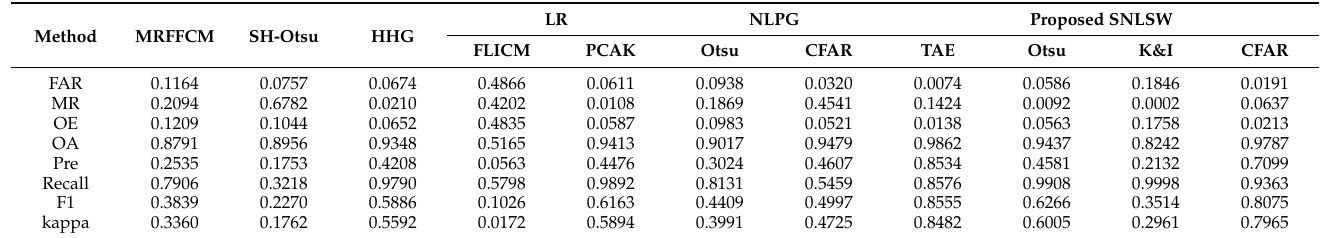
Table 3. Quantitative evaluation of the different methods on Dataset #3.